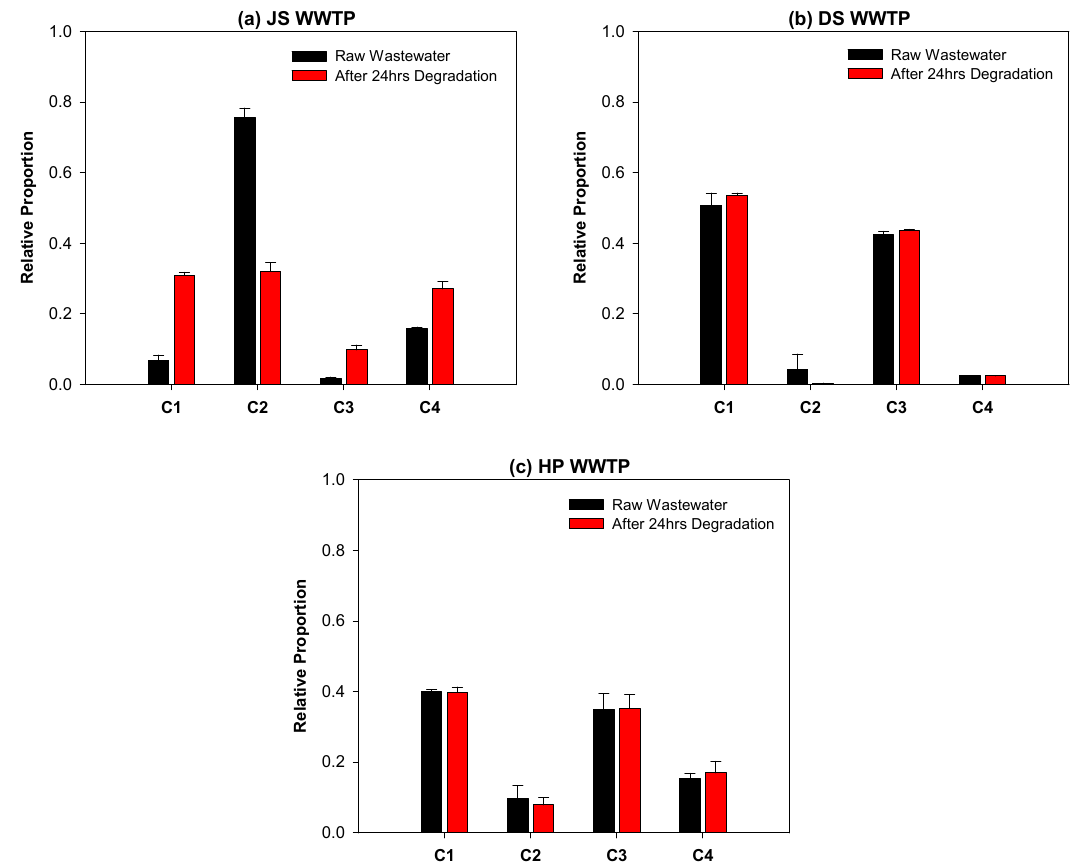
Figure 5. Relative fractions of the protein-like (C1), tryptophan-like (C2), tyrosine-like (C3), and fulvic-like (C4) components of the wastewater dissolved organic matter in ( a ) JS; ( b ) DS; and ( c ) HP WWTPs. The black and red bars indicate the relative fractions before and after the 24-h biodegradation test, respectively.